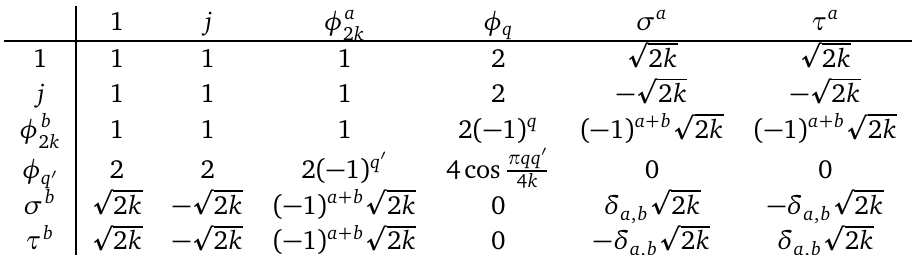
(cid:112) = 1 / ( 4 k ) . The labels 1,1